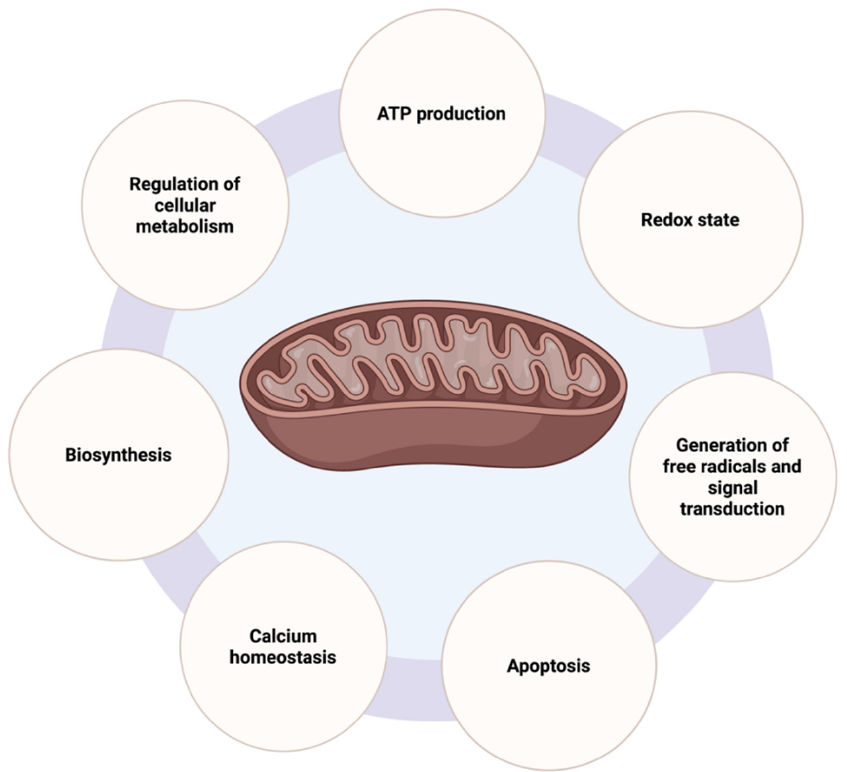
Figure 1. Schematic representation of the main mitochondrial functions in a cell. Created with Biorender.com (accessed on 21 February 2022; Toronto, ON, Canada) (ATP—adenosine triphosphate).